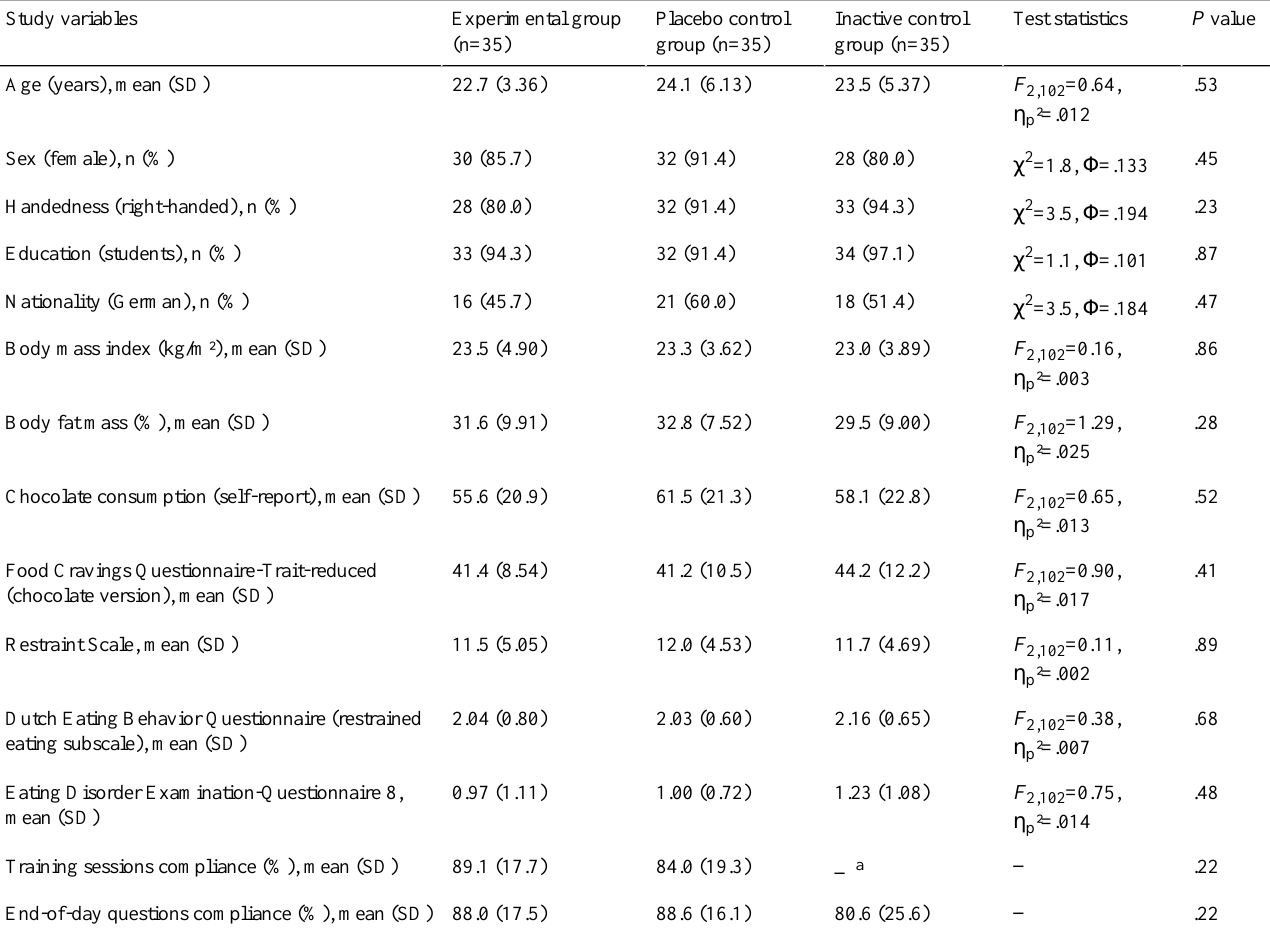
Table 1. Means and frequencies of study variables at pretest and compliance rates during the intervention phase as a function of the group (N=105).